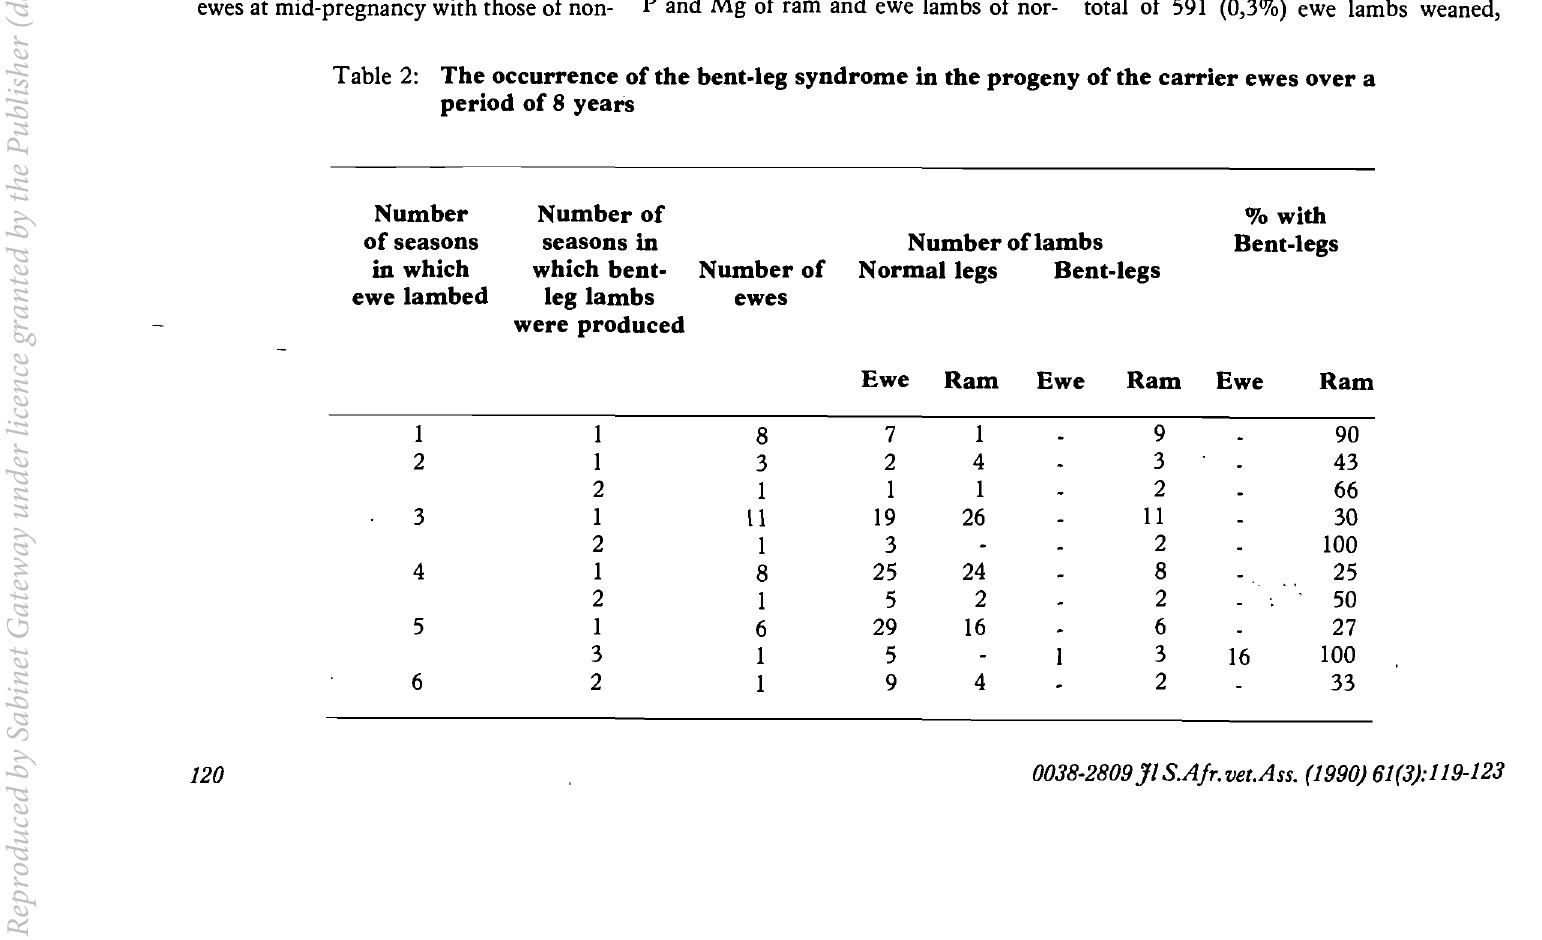
Table 2: The occurrence of the bent-leg syndrome in the progeny of the carrier ewes over